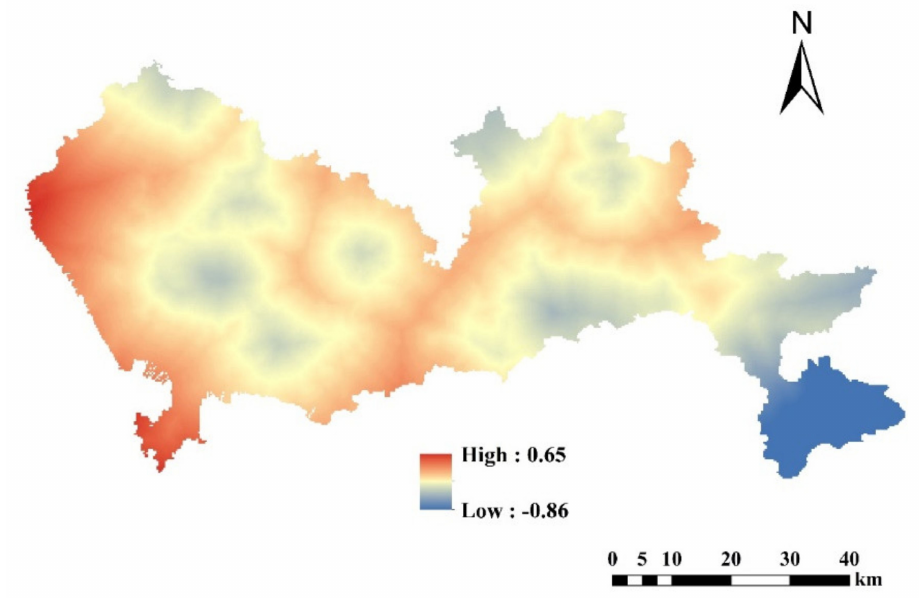
Figure 7. Distribution of the minimum cumulative resistance